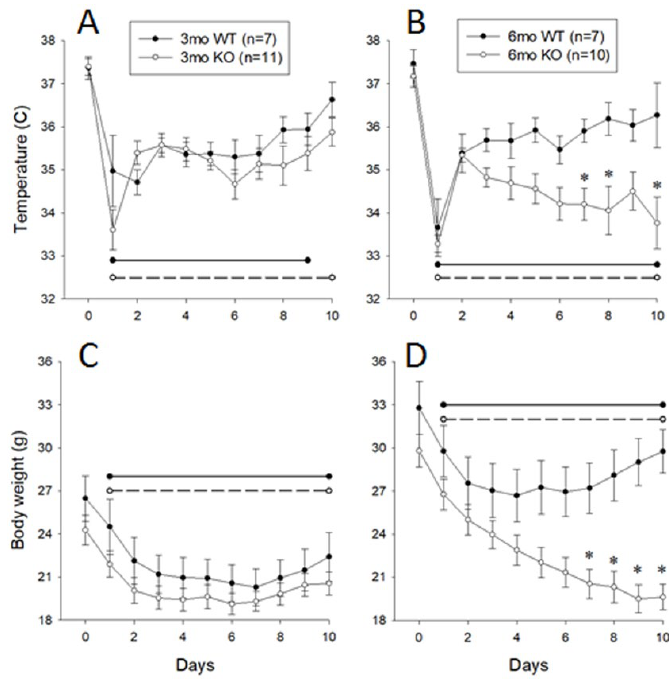
Figure 3. Daily temperature and body weight of ALOX8 +/+ and ALOX8 − / − mice before and after influenza inoculation. Mice were implanted with subcutaneous chips to allow remote acquisition of body temperature. Temperature and body weights were measured daily before and for 10 days after influenza inoculation. Data are presented as average daily values ± SEM. Left panels show body temperature ( A ) and weight ( C ) data from 3-month-old mice ( n = 7 ALOX8 +/+ mice and n = 11 ALOX8 − / − mice); right panels show body temperature ( B ) and weight ( D ) data from 6-month-old mice ( n = 7 ALOX8 +/+ mice and n = 10 ALOX8 − / − mice). Horizontal lines denote significant di ff erences from baseline values ( ALOX8 +/+ , solid; ALOX8 − / − , dashed). Asterisks denote significant di ff erence between ALOX8 +/+ and ALOX8 − / − mice at the designated time point.